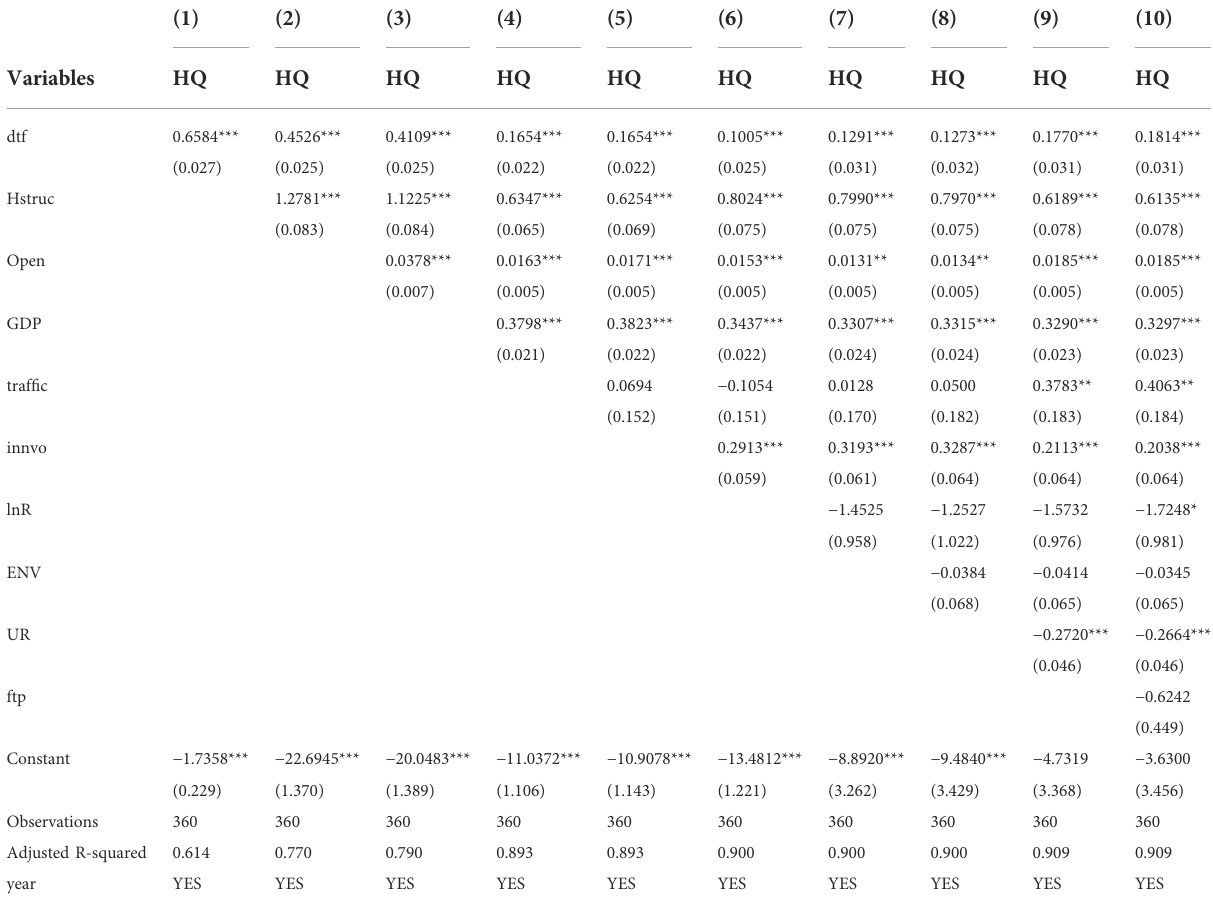
TABLE 7 Estimate results of benchmark